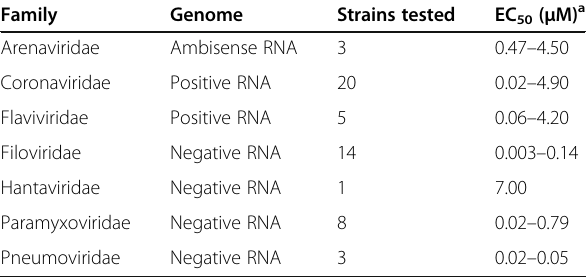
Table 1 Broad-spectrum antiviral activity Family